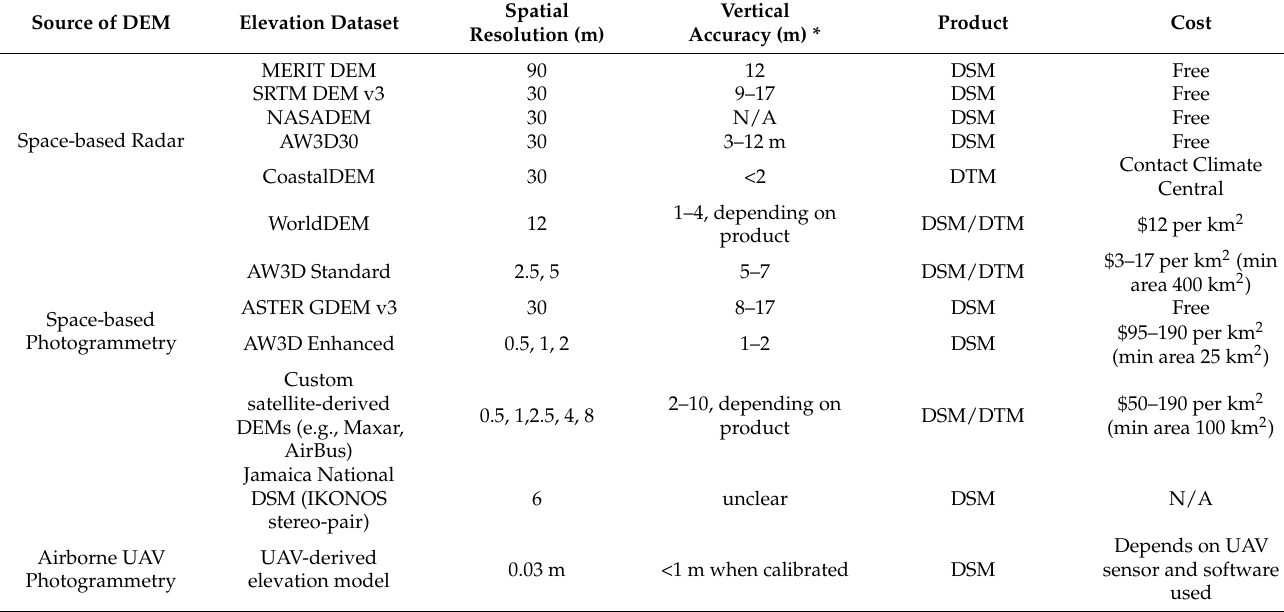
Table 1. Available Digital Elevation Models (DEM) for